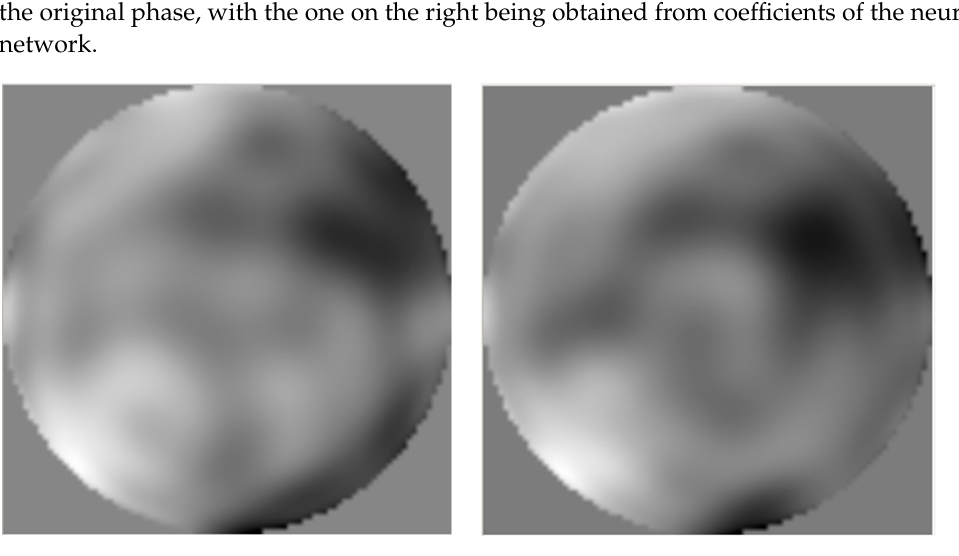
Table 2. Residual WFE obtained by the reconstructions made by the MLP in comparison with the original WFE for the second experiment.